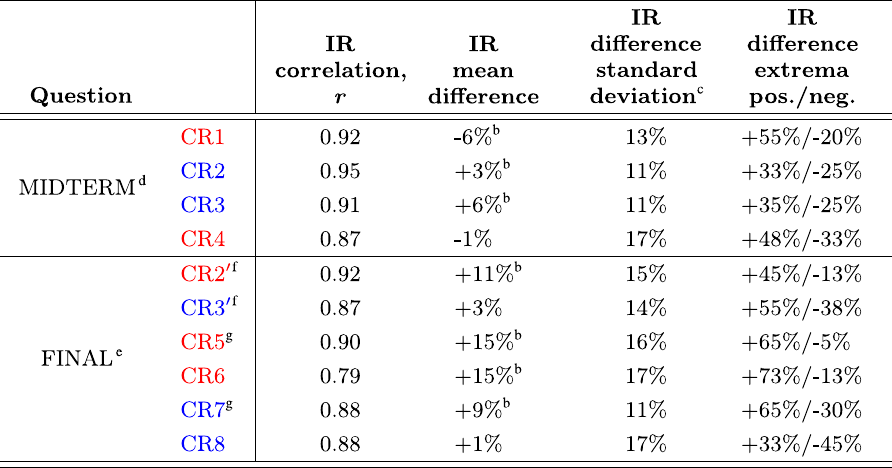
TABLE II. Interrater (IR) a reliability for constructed-response